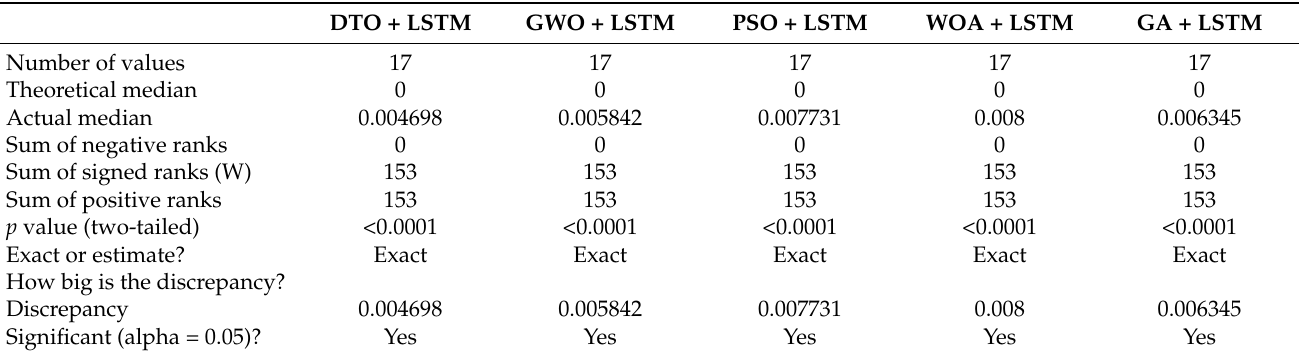
Table 5. Results of the Wilcoxon signed-rank